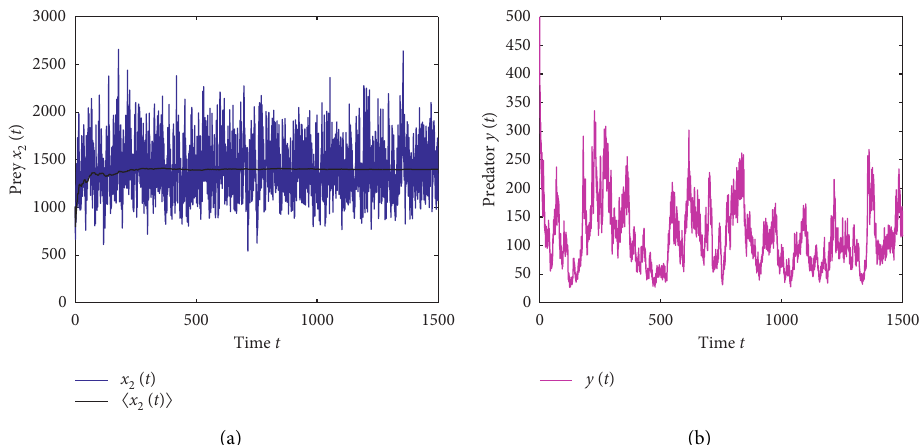
Figure 14: The trajectories of (5) with σ 2 (b) predator y ( t ) .